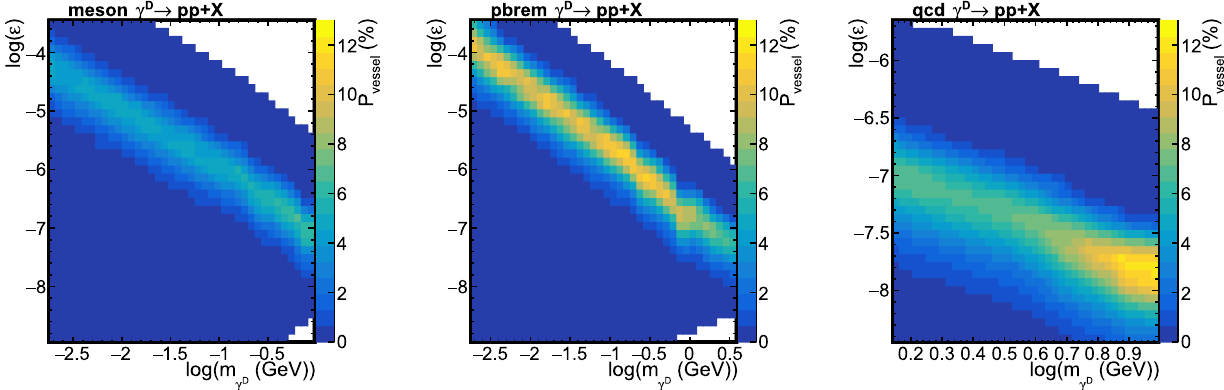
Fig. 10 Efficiency of requiring the γ D decay vertex to be inside the decay vessel volume, for the three production modes studied. An interpolation between the simulated ( m γ D , ε ) values is performed using a linear interpolation via Delaunay triangulation